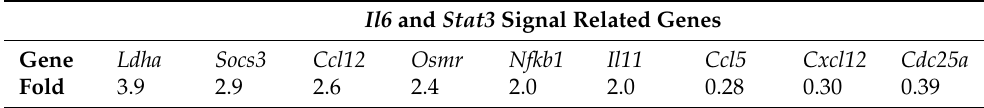
Table A2. DEGs related to Il6 and Stat3 signals in the PBOO